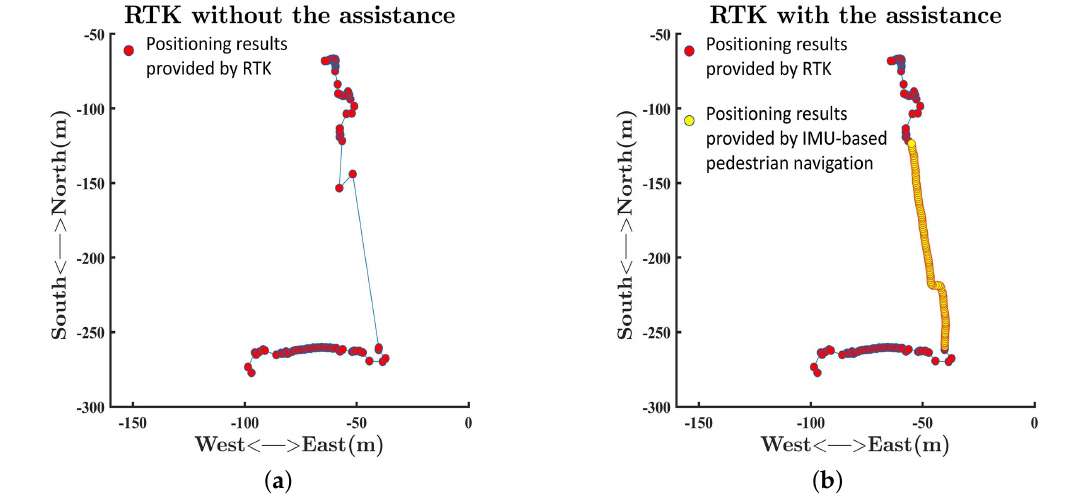
Figure 15. Comparison between the performances of RTK without the assistance of an IMU-based pedestrian navigation algorithm and RTK with the assistance of an IMU-based pedestrian navigation algorithm.